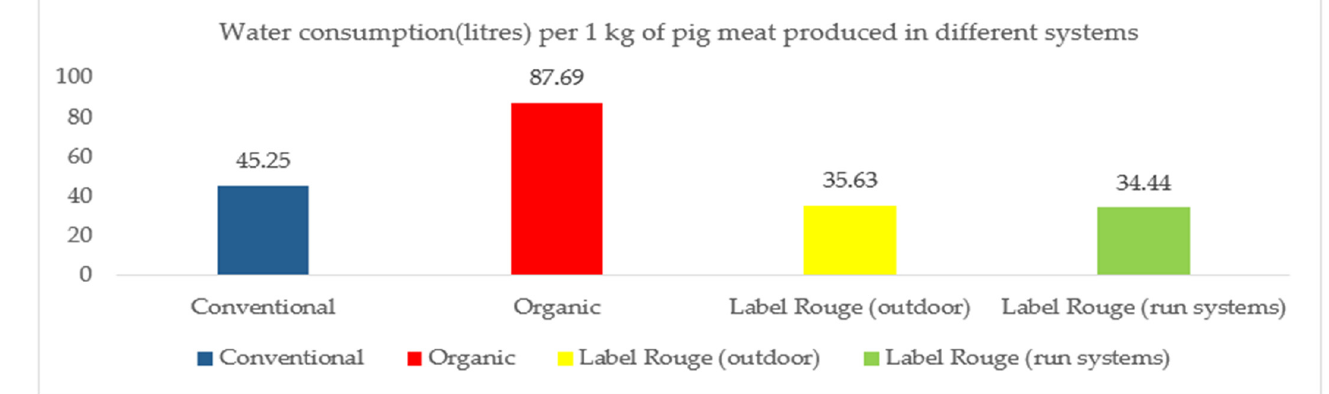
Figure 3. Water consumption per 1 kg Pig meat across organic, Label Rouge and Conventional systems: Data obtained from AGRIBALYSE ® database and computed using OpenLCA 1.10.2 [35,36].